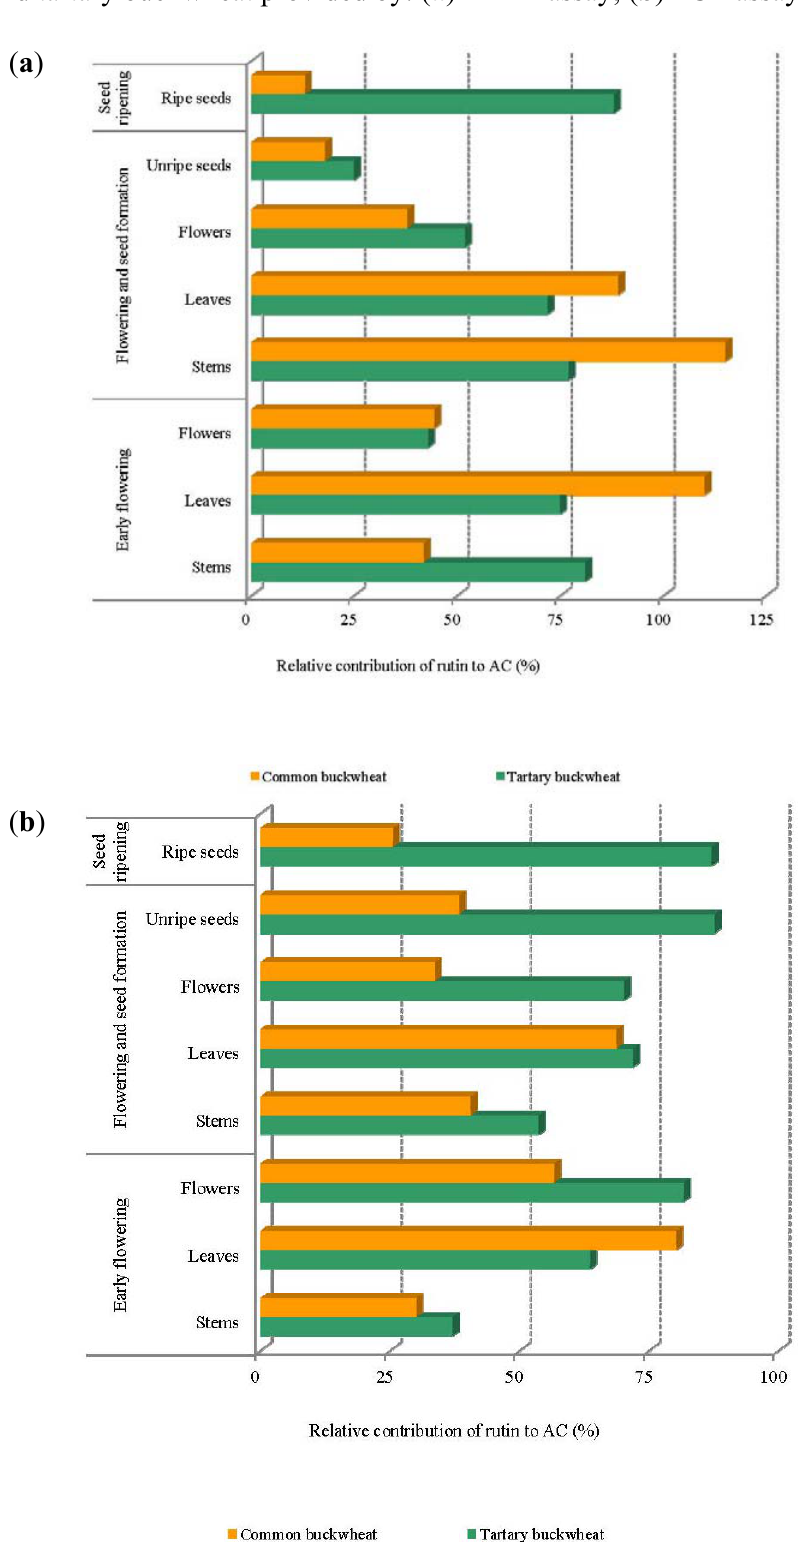
Figure 3. The contribution of rutin to the antioxidant capacity of the aerial parts of common and tartary buckwheat provided by: ( a ) DPPH assay; ( b ) PCL